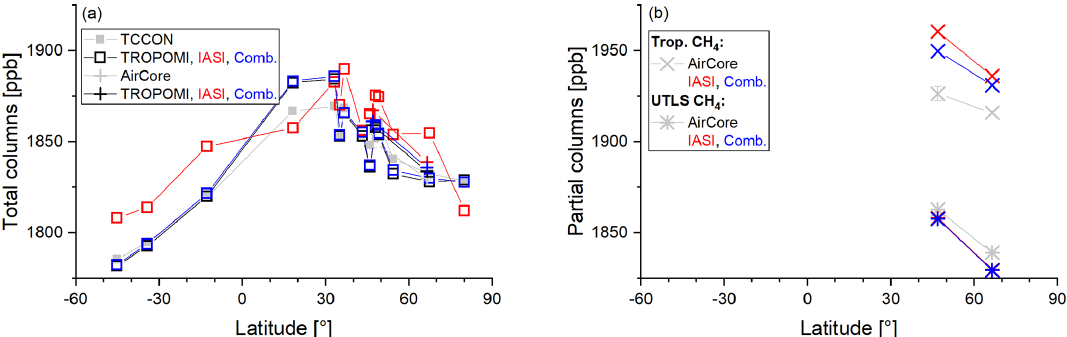
Figure 14. Latitudinal dependency of the overall mean values obtained at the 14 TCCON and two AirCore observation sites. Grey colour represents the TCCON and AirCore reference data and black, red, and blue colours the TROPOMI, MUSICA IASI, and combined satellite data, respectively: (a) for total columns (XCH 4 ) and (b) for tropospheric and UTLS partial columns. The error bars on the AirCore data describe the variability range due to the AirCore data treatment – according to Eq. (7) – with the different averaging kernels of the TROPOMI, MUSICA IASI, and combined data